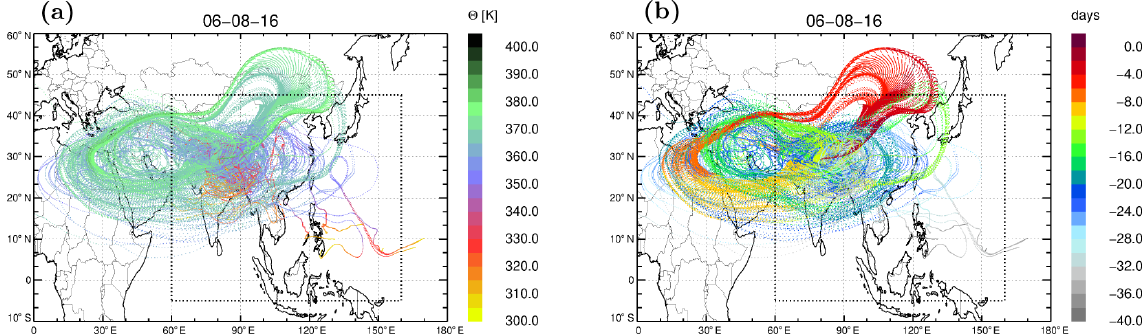
Figure 5. Forty-day backward trajectories initialised within the ATAL on 6 August 2016 originating in the BL (same trajectories as shown in Fig. 4a), colour-coded by potential temperature (a) and by days back from 6 August 2016 (b) . In a latitude–longitude box from 60 to 160 ◦ E and from 5 ◦ S to 45 ◦ N, indicated by dashed lines, the air mass origin in the BL is further analysed (see Fig. 6, Table 3)